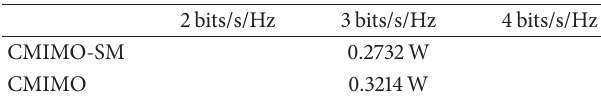
Table 3: Circuit power consumption 𝑃 𝑐 for 2 bits/s/Hz, 3bits/s/Hz, and 4bits/s/Hz transmissions using CMIMO-SM and CMIMO.